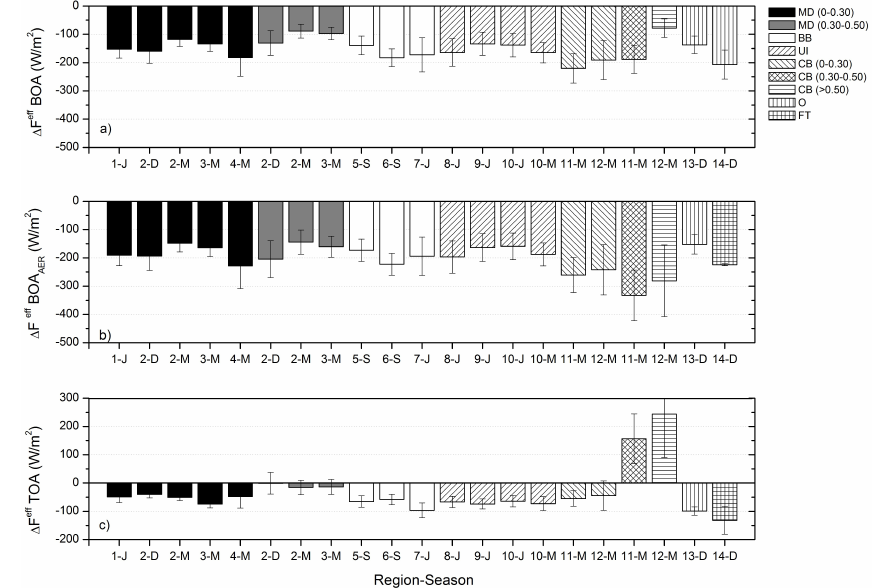
Fig. 7. Multi-year average of the radiative forcing efficiency, 1F eff (Wm − 2 ), at the BOA (a) , AERONET 1F eff BOA AER at the BOA (b) , and 1F eff at the TOA (c) for each region and season. The seasons and aerosol types are labeled as Fig. 5. Error bars indicate ± 1 σ ( σ , standard